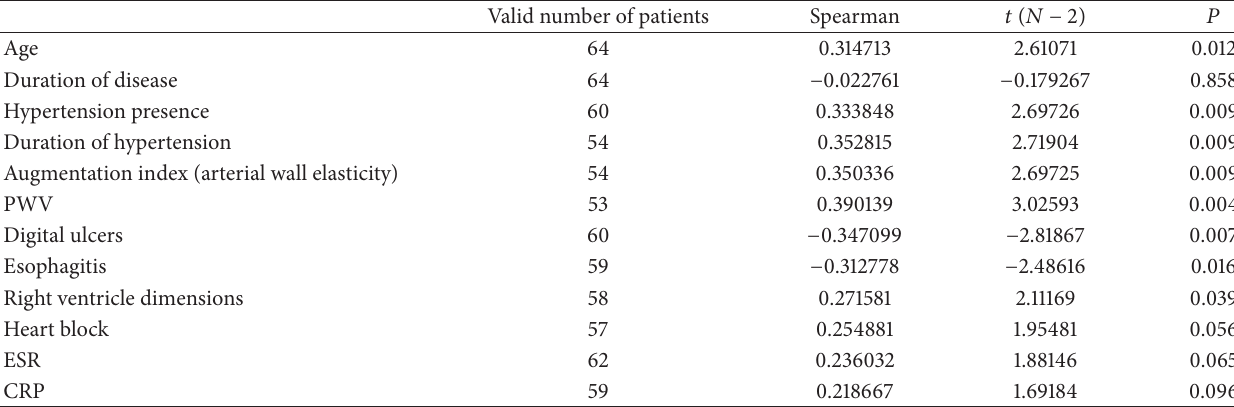
Table 5: Correlation of anti-hnRNP B1 autoantibodies with clinical characteristics of patients with SSc. Valid number of